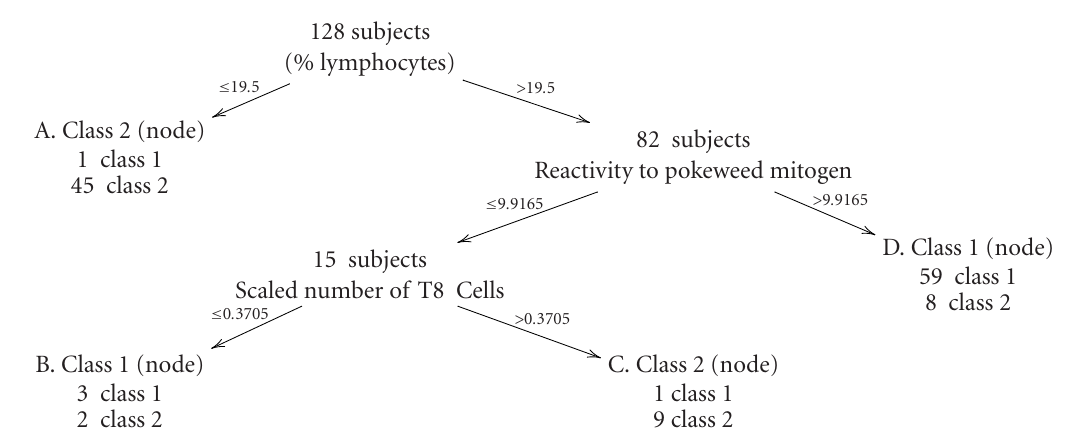
Figure 1. An example of neural network black box: a four-dimensional data input x is first transformed by W , then by h in order to give a grouping variable y as an